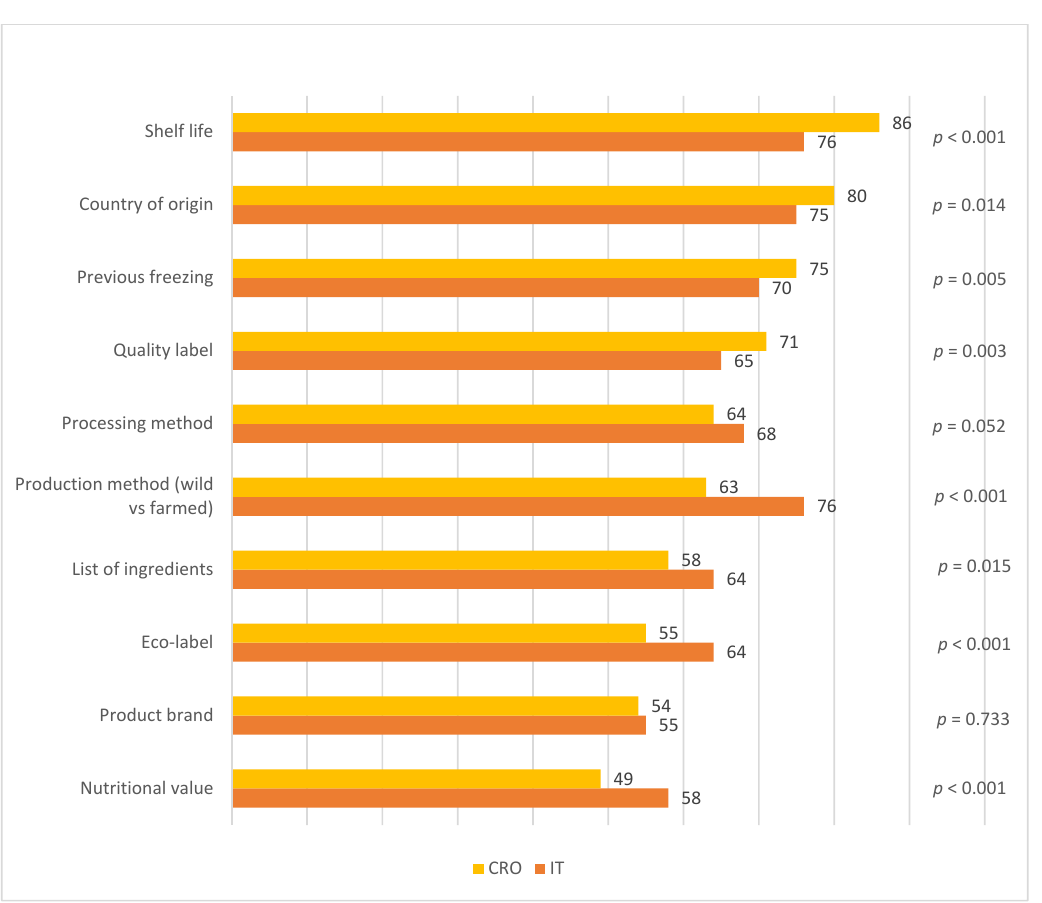
Figure 2. Participants’ ranking of the importance of product information in Croatia and Italy (% of participants).